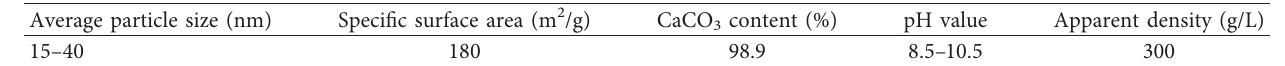
Table 2: Physical properties of nano-CaCO